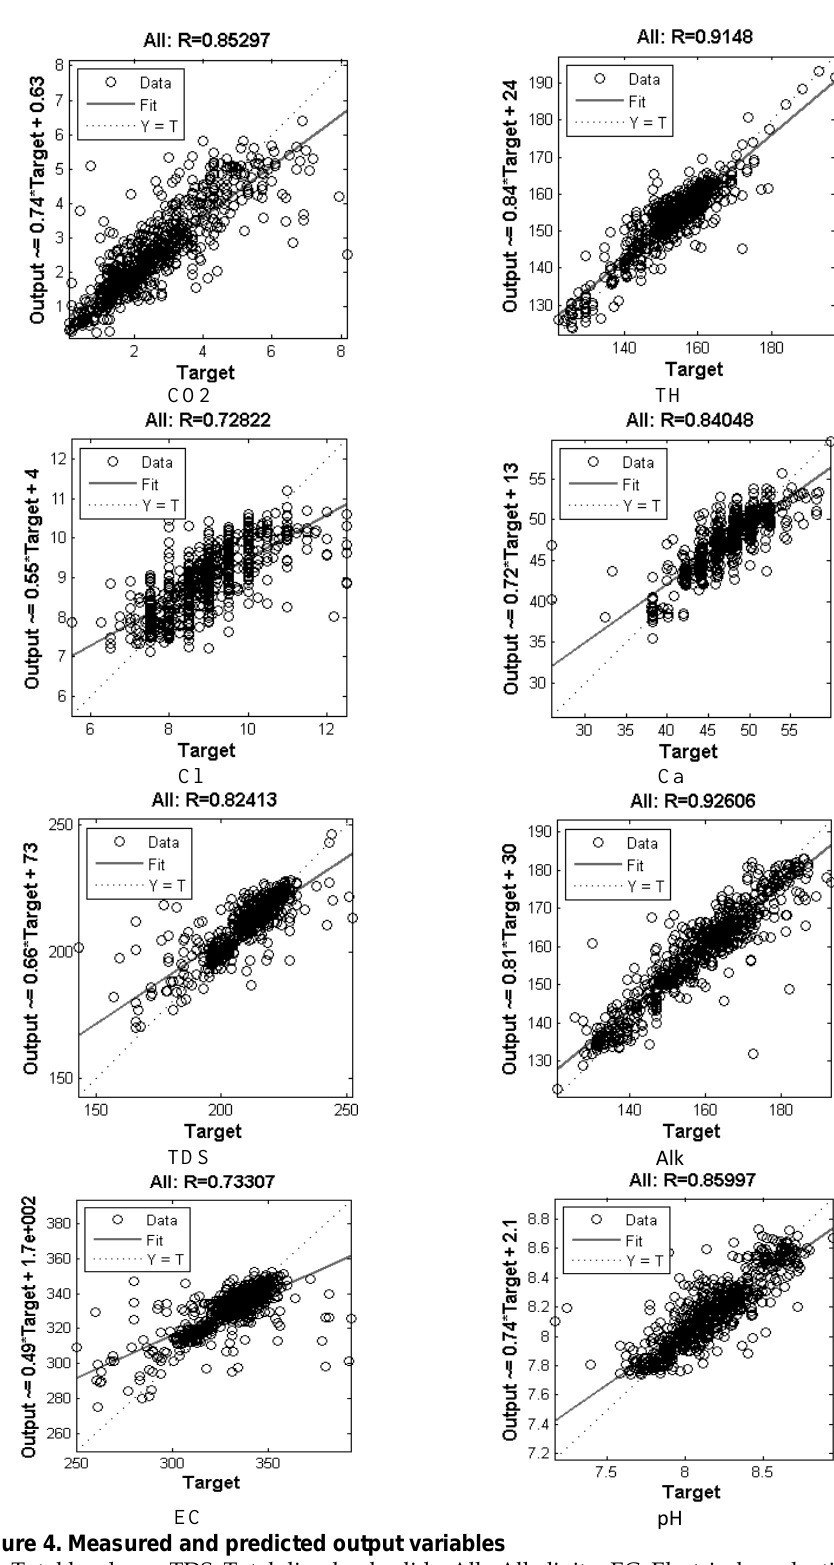
Figure 4. Measured and predicted output variables TH: Total hardness; TDS: Total dissolved solids; Alk: Alkalinity; EC: Electrical